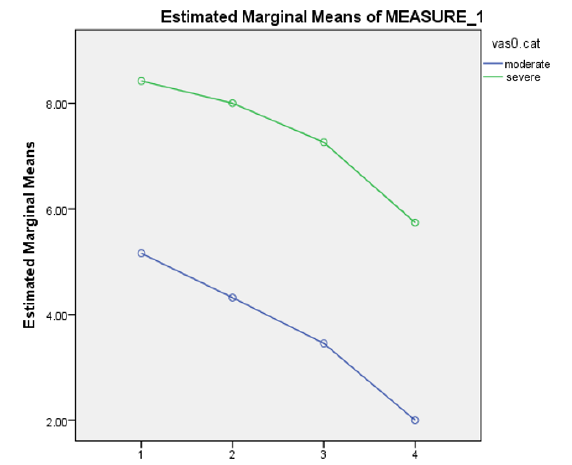
Figure 1. Mean of pain severity at various times in the two groups of patients with severe and moderate